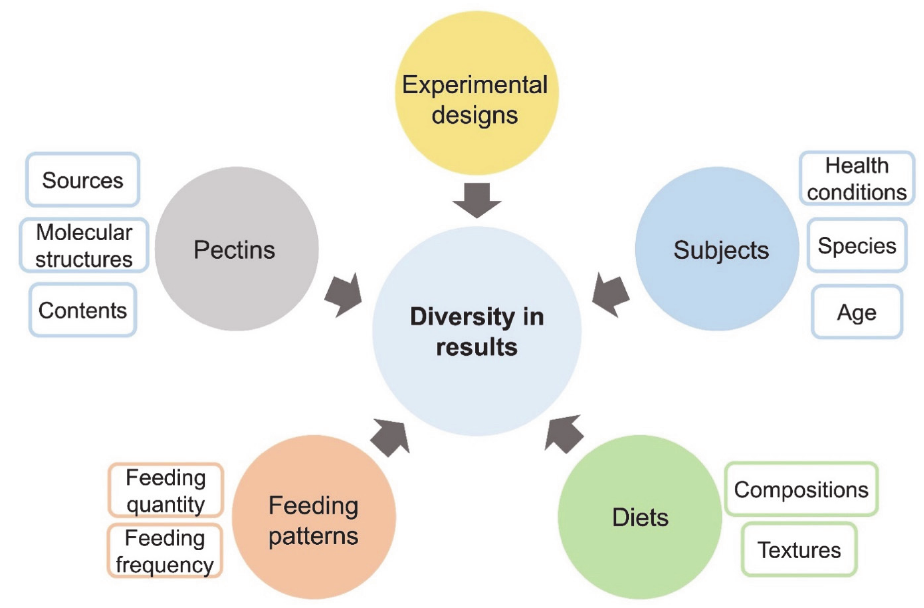
Figure 2. Experimental factors that may vary pectin’s effects on starch